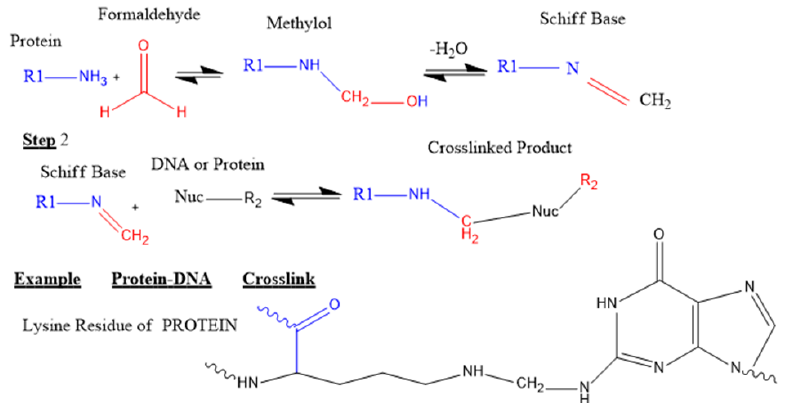
Figure 3. Chemical reactions of protein–DNA crosslinking by formaldehyde: Crosslinking of protein–DNA by formaldehyde occurs in two steps. Firstly, a strong nucleophile, commonly a lysine є-amino group from a protein, reacts with formaldehyde to form a methylol intermediate which will lose water to give a Schiff base (an imine). Secondly, the Schiff base reacts with another nucleophile amine of a DNA to generate a crosslinked product. The latter nucleophile might also be from another protein or the same protein as the first nucleophile. All the reactions in this stoichiometric process are reversible. Modified from Hoffman et al. (2015) [97].